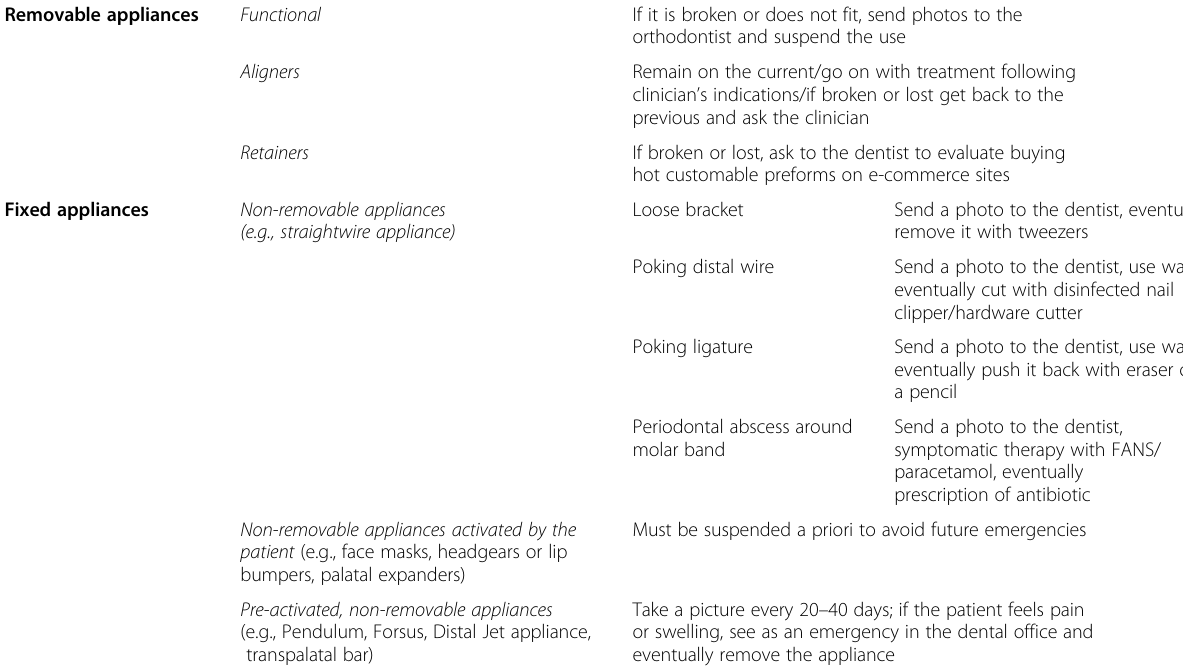
Table 1 Orthodontic emergency scenarios and how to resolve them Removable